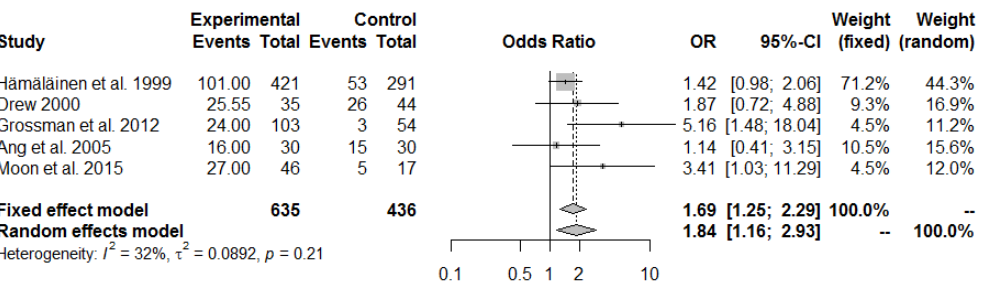
Figure 4. Pulled ORs of pain in the lumbar spine in fighter pilots vs. transport pilots. Study shows first author and year of publication; [3,27–30]. 3.2. Prevalence of Neck and Lumbar Pain Due to the impossibility of calculating risk indicators, as there were no reference groups for the studies conducted, this section is limited to only the description of the out- comes. The analysis presented in Table 3 indicates that some research findings recom- mended warming up and stretching the neck muscles as part of a “G-force warm-up” in the cockpit prior to exposure to high Gz forces [3,24]. One case showed a statistically sig- nificant beneficial effect of warm-up or isometrics [24], but others, for 95 pilots [25] and 52 pilots [6], showed no benefit. In-flight techniques include the use of external head and neck support in the cockpit during and prior to high Gz forces, and pre-positioning of the head prior to the arrival of Gz forces [3,6,24]. Two studies [3,24] showed a significant de- crease in neck injuries in F-16 pilots who rested their head against the seat before the high Gz force occurred. In the case of lumbar support, neither the individualization of the level and shape of the support, [37] nor the backrest inclination angle [3] were statistically sig- nificantly effective at reducing the risk of injury to this spinal segment due to high +Gz force values. Many researchers have used different forms of strength training designed specifically for neck muscles [3,6,24], as well as whole body training including functional training or a combination of these options [3,24,25,36,37,39–42]. Whole body training in- cluding functional training or a combination of these training options has also been used for the lumbar spine [3,37,41]. Approximately half of the studies involving neck pain did